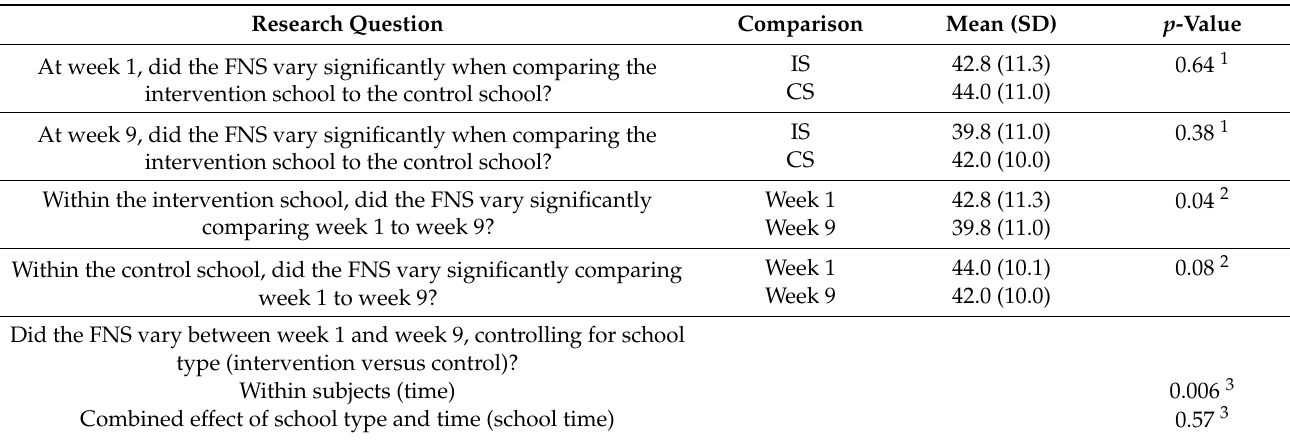
Table 2. Food neophobia scale (FNS) research question analysis statistics comparing the intervention school (IS) to the control school (CS), comparing week 1 to week 9, and examining interaction between school type (IS versus CS) and time (week 1 versus week